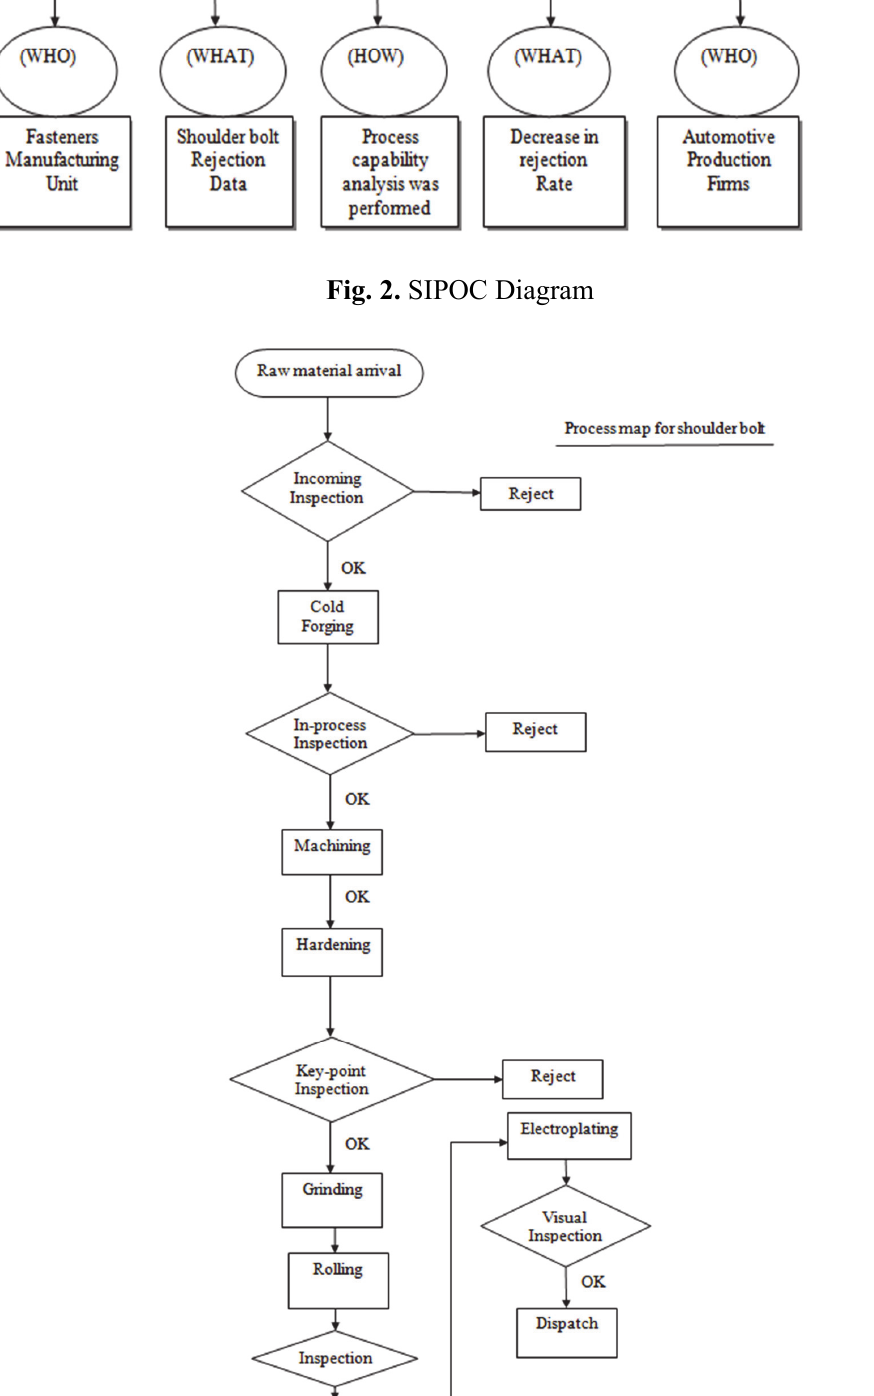
Fig. 3. Process Map for Shoulder